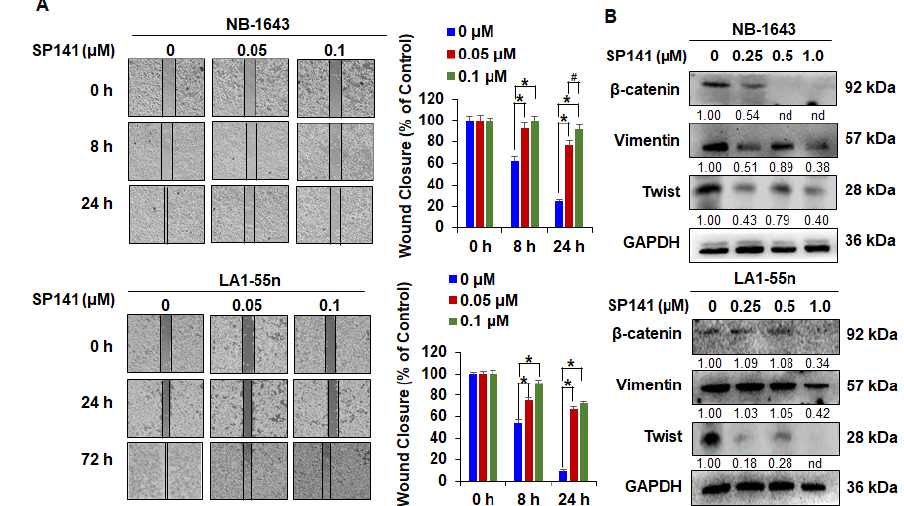
Figure 3. SP141 inhibits the migration of neuroblastoma cells. ( A ) NB-1643 and LA1-55n cells were grown to confluence in a six-well plate and a scratch was made at experimental time zero. The cells were exposed to various concentrations of SP141, and the wells were imaged at di ff erent time points. Graphs (right panel) show the quantitative results of wound closure. ( B ) NB-1643 and LA1-55n cells were treated with various concentrations of SP141 for 24h, then Western blot analyses were performed to assess the expression of epithelial-mesenchymal transition (EMT)-related molecular markers. All band intensities were determined using the ImageJ software and are shown normalized to the control lane for each target. “nd” denotes “not detected”. All assays were performed in triplicate, and all experiments were repeated at least three times. Representative data are shown. Where applicable, the data were analyzed by Student’s t -test and results are shown as the means ± SEM. ( # p < 0.05, * p <